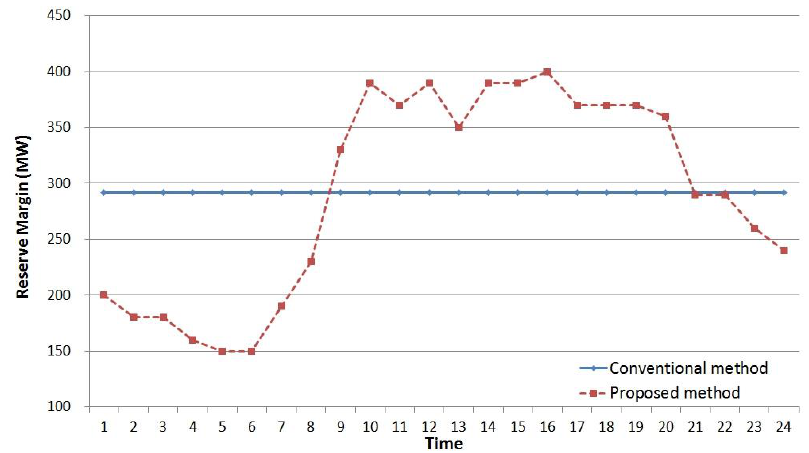
Figure 5. Hourly reserve margins for the conventional method (a fixed reserve margin of 292 MW) and the proposed method (based on a short-term reliability of balance of 99.6%).